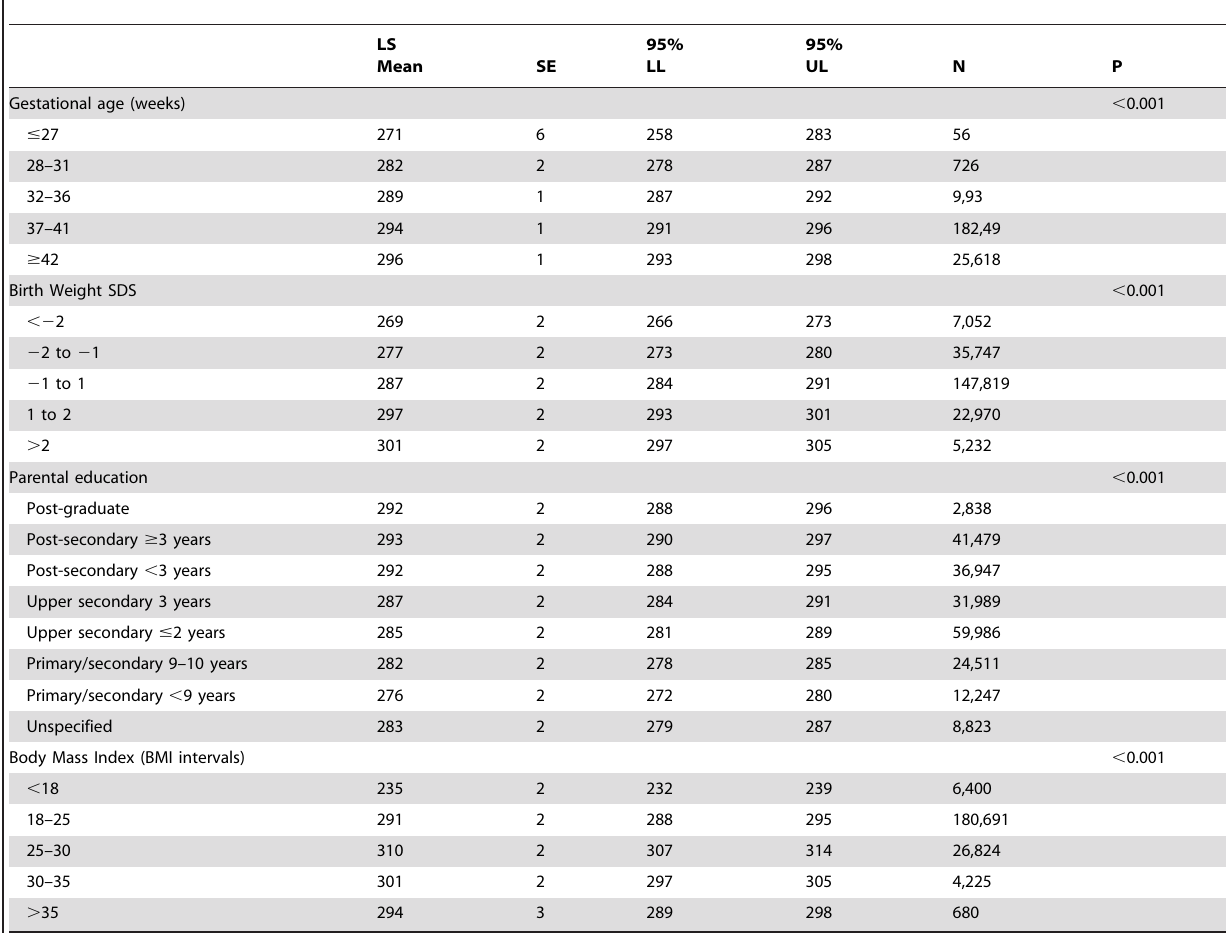
Table 8. Maximal exercise capacity and major risk factors (General Linear